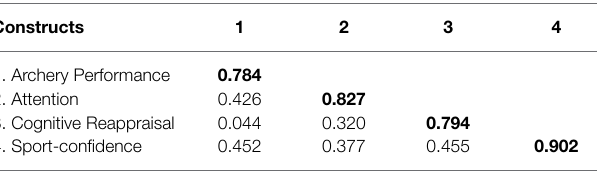
TABLE 3 | Fornell–Larcker criterion analyses.